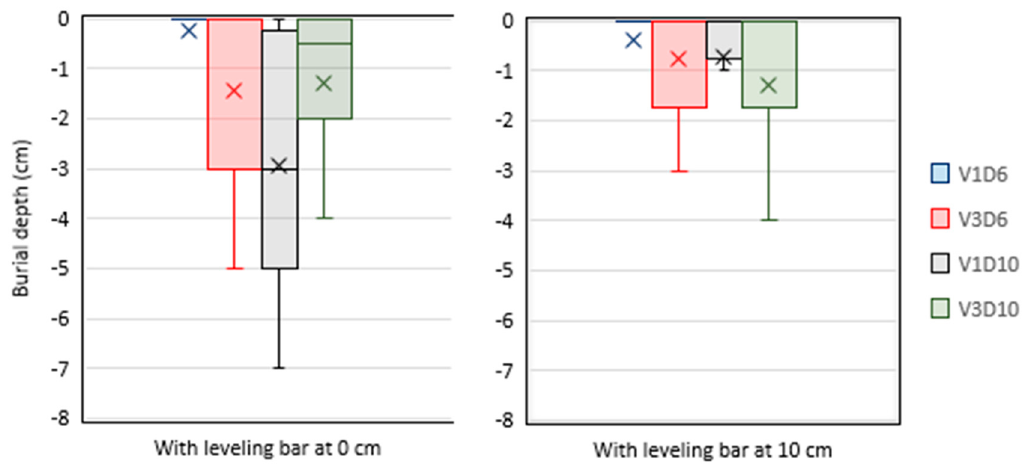
Figure 7. Average trackers burial depth at different working conditions.